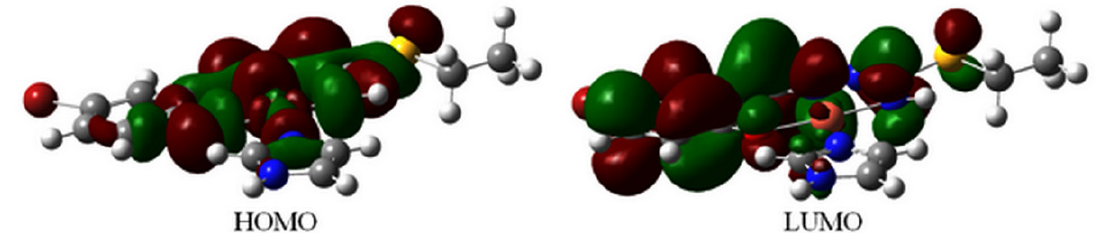
Figure 3. Contour plots of the HOMO and LUMO orbitals of the Cu(II) complex. Table 3. Electron population, spin densities and charge of central ion, nitrogen and oxygen atoms. atom Electron population spin of the valence core